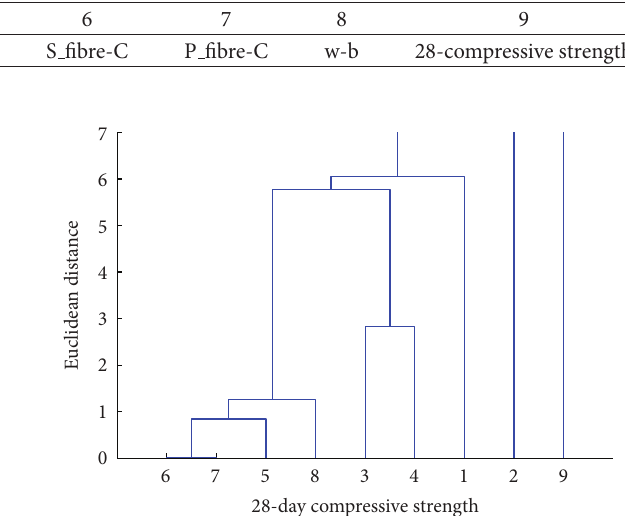
Figure 20: Plot of experimental results from [6, 8,